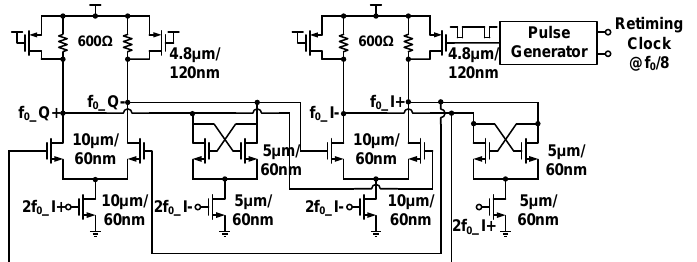
Figure 12. Circuit schematic of the CML quadrature divider with periodic pulse injection.